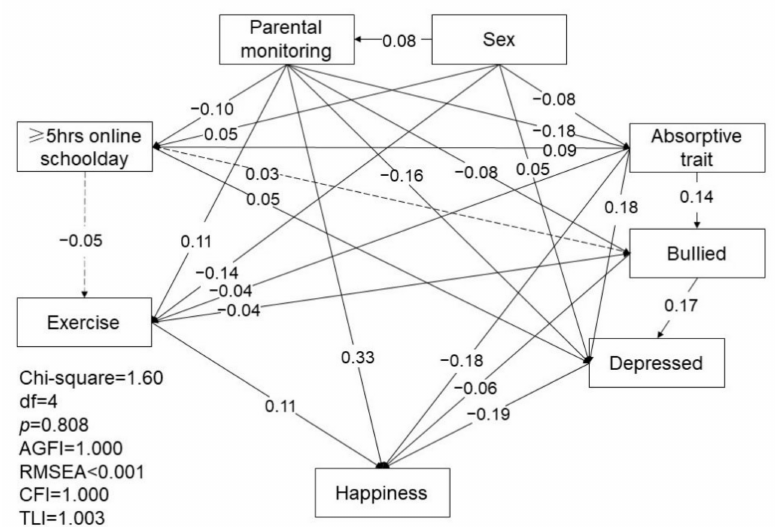
Figure 2. The path relationships of risk and protective factors for five hours of internet use on mood and happiness in 12-year-olds. “ ≥ 5 h online schoolday” dummy variable: 1 = spend ≥ 5 h online during schooldays, 0 = spend ≤ 1 h online during schooldays. AGFI: adjusted goodness-of-fit; RMSEA: root mean square error of approximation; CFI: comparative fit index; TLI: comparative fit